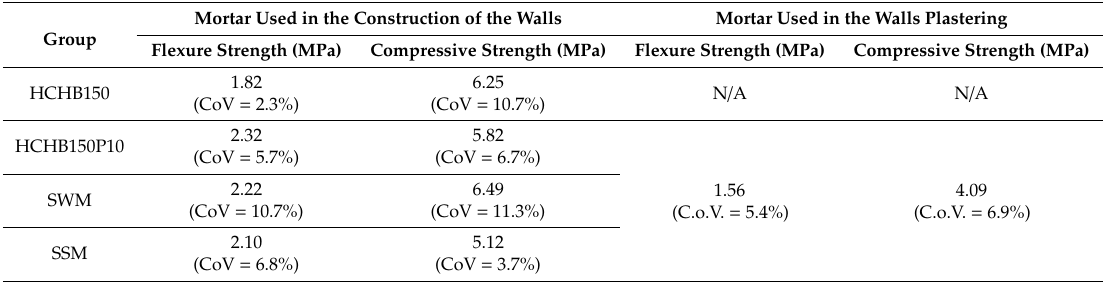
Table 1. Results from flexure and compressive strength tests on mortar